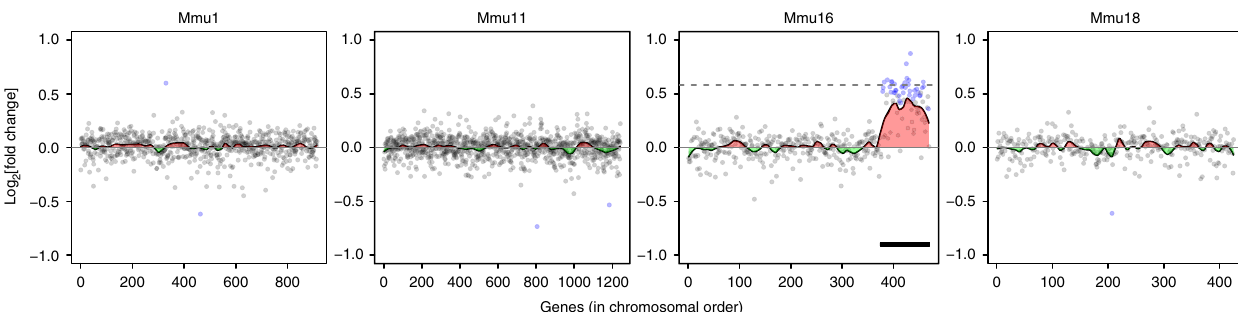
Fig. 2 Change in expression in Dp1Tyb mouse embryonic fi broblasts (MEFs) as a function of chromosomal position. Plots show fold change of gene expression in Dp1Tyb MEFs vs wild-type control cells. Expressed genes are plotted in chromosomal order on the four example chromosomes. Genes that are signi fi cantly differentially expressed are indicated with blue dots, other genes are in grey. A Loess smoothing curve is superimposed with regions that are upregulated or downregulated indicated in red or green. Dashed line on Mmu16 indicates a fold change of 1.5. Note the upregulation of genes in the duplicated region on Mmu16 (thick black